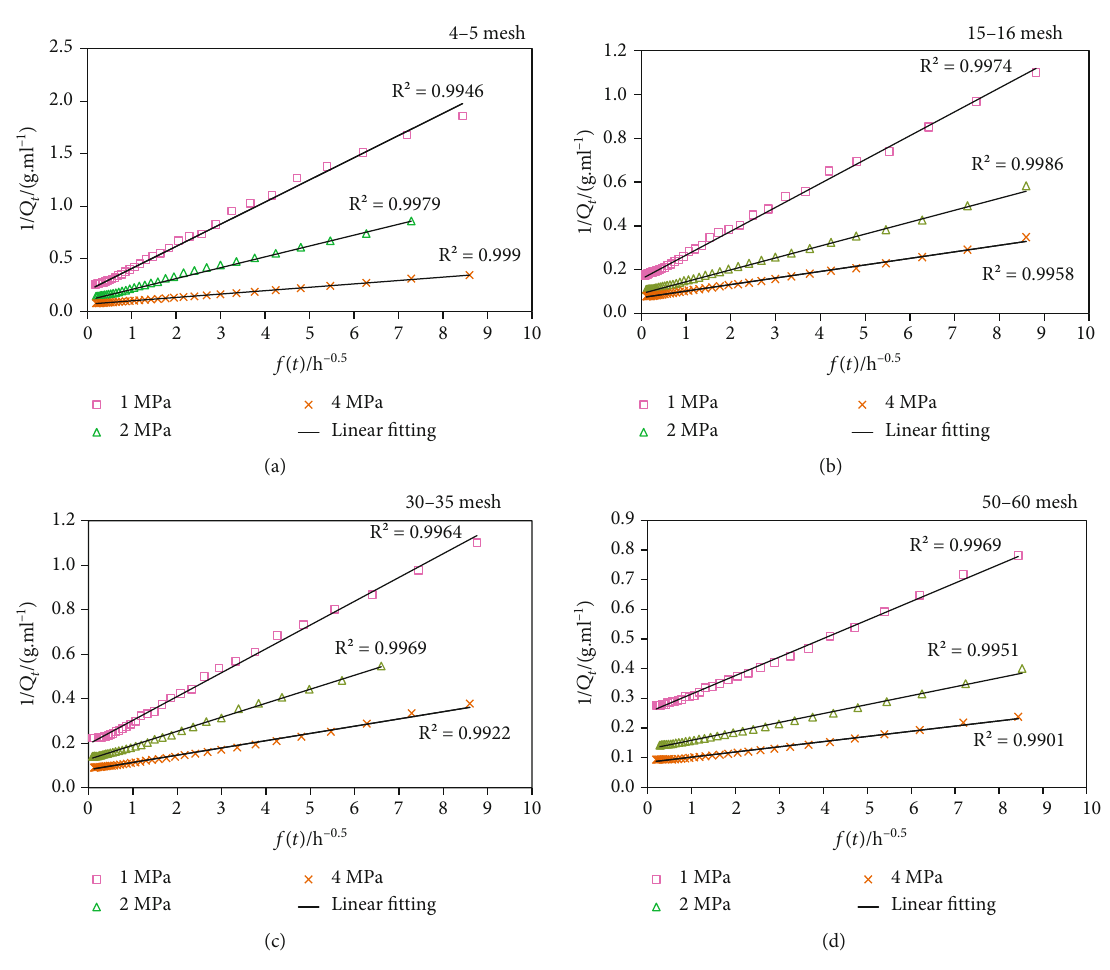
Figure 3: Curves of 1/ Q and f ð t Þ under di ff erent initial pressures. Table 2: Parameter values of A